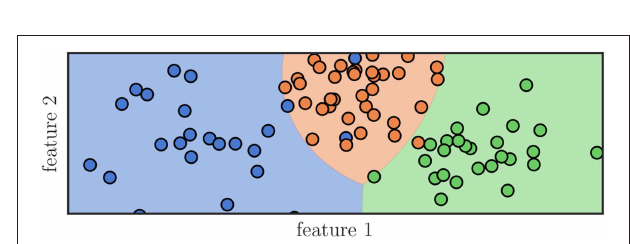
FIGURE 2 | Graphical representation of a classification algorithm using two features to classify samples into three distinct classes, represented by their color. A Gaussian naive Bayes classifier was trained using the samples seen as dots and subsequently the areas, whose feature combination would lead to a specific classification, was colored accordingly. It can be seen that not all samples would be classified correctly even though they have been part of